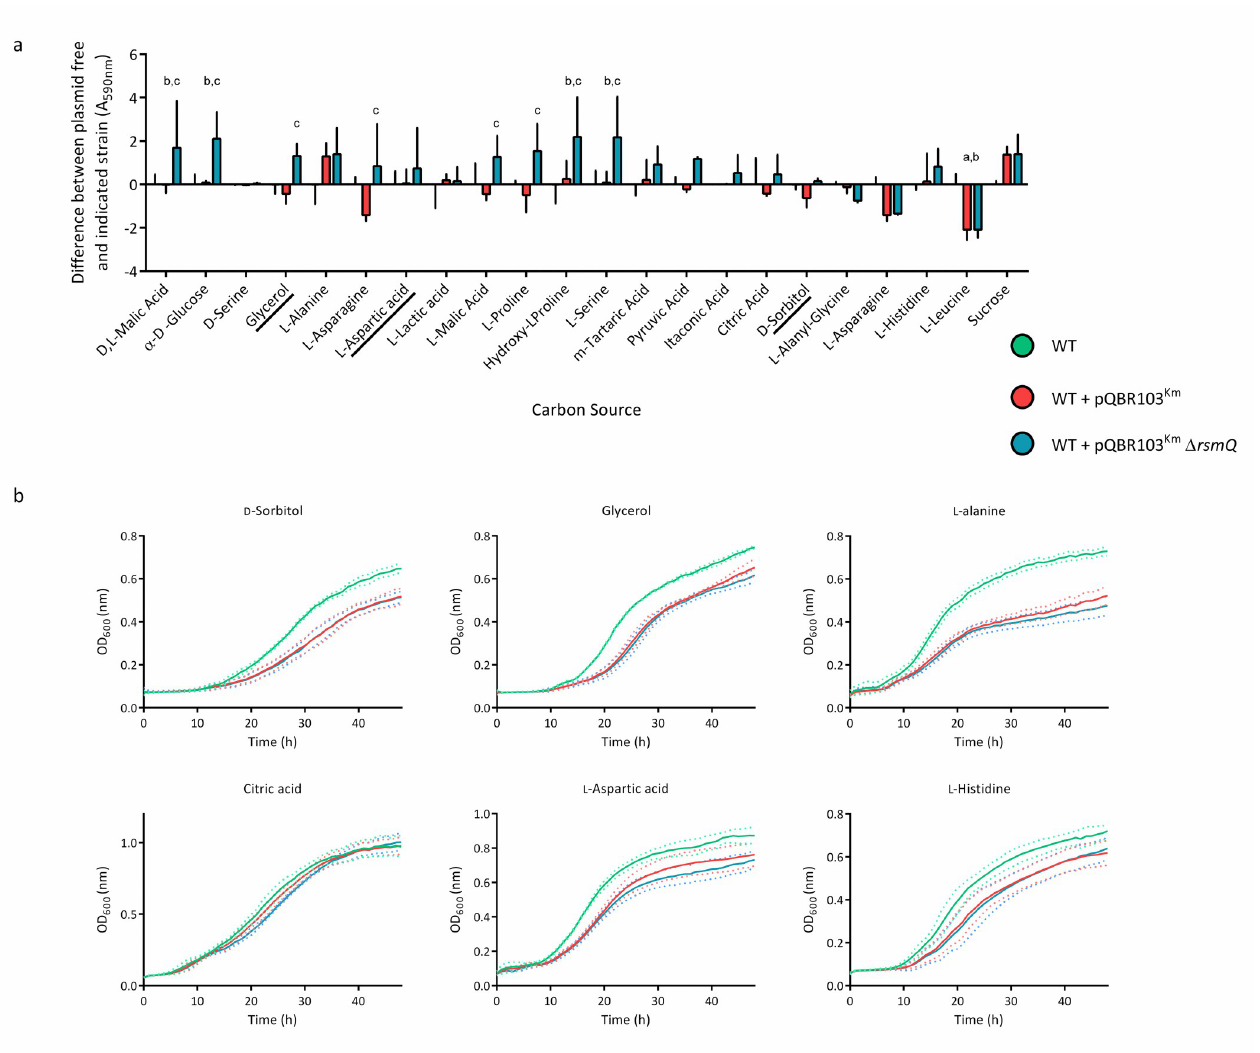
Fig 8. RsmQ is involved in the control of carbon source metabolism. (a) Selected results from BioLog carbon source screens showing metabolism with relevant carbon sources after 48 h of static incubation at 28˚C. Data are shown for SBW25 cells carrying pQBR103 Km (red) and pQBR103 Km - Δ rsmQ (blue) compared to average SBW25 plasmid free (green) for each carbon source. Error bars show standard deviation. A two-way ANOVA showed a significant effect of strain and carbon source ( p < 0.0001) as well as a significant interaction ( p < 0.01). Multiple comparisons compared SBW25 plasmid free, SBW25 +pQBR103 Km and SBW25 +pQBR103 Km - Δ rsmQ within each carbon source. Significant differences are indicated above for SBW25/SBW25 +pQBR103 Km (a), SBW25/SBW25 +pQBR103 Km - Δ rsmQ (b), and SBW25 +pQBR103 Km /SBW25 +pQBR103 Km - Δ rsmQ (c) for p < 0.05. Data for all carbon sources can be seen in S10 Fig and S2 Table. (b) Growth curves are shown for SBW25 (green), SBW25 cells carrying pQBR103 Km (red), and pQBR103 Km - Δ rsmQ (blue), with the mean growth for 3 biological replicates shown as a solid line and standard deviation shown as dotted lines. Cells were grown for 48 h at 28˚C without shaking in M9 minimal media with 0.4% w/v either D-sorbitol, glycerol, L-alanine, citric acid, L-aspartic acid, L-histidine as indicated. Data are available in S7 Data. WT,